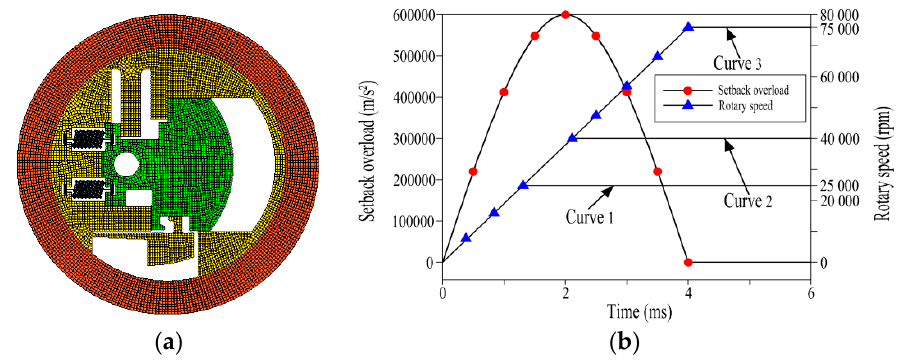
Figure 4. Simulation analysis of the micro S & A module in ANSYS/LS-DYNA. ( a ) The finite element model of micro S & A module; ( b ) The centrifugal and overload force application curve [4,16].